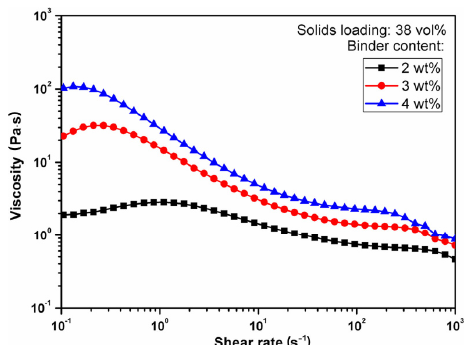
Fig. 3 Viscosity of AlN slurries with different PIBM content (solids loading: 38